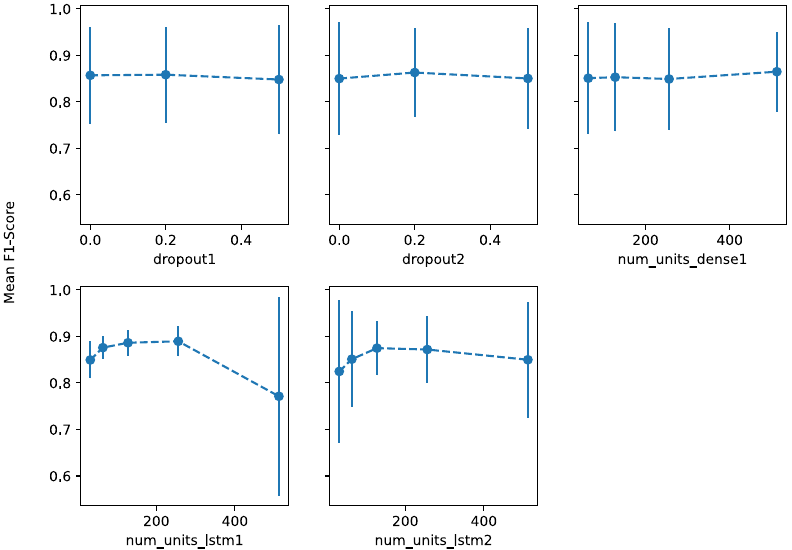
Figure 11. Mean test performance of RNN models for respective evaluated hyperparameters with standard deviation. Table 10. Used hyperparameters for the training of the best